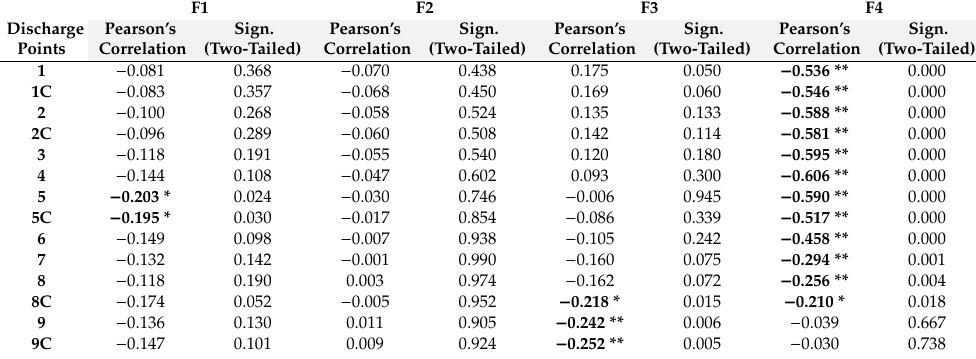
Table 3. Correlation coe ffi cients between the vari-factors obtained by principal component analysis (PCA) / factor analysis (FA) and their distances from the sewage discharges. The correlations highlighted in bold and with a superscript are significant. The number of data are